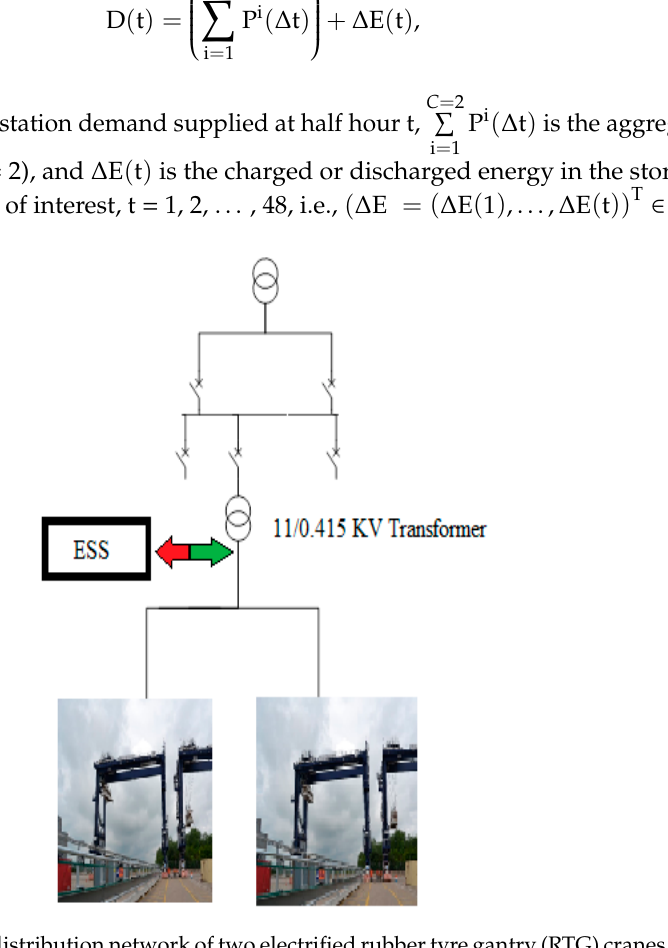
Figure 1. The electrical distribution network of two electrified rubber tyre gantry (RTG) cranes equipped with an energy storage system (ESS) at the Port of Felixstowe, UK.